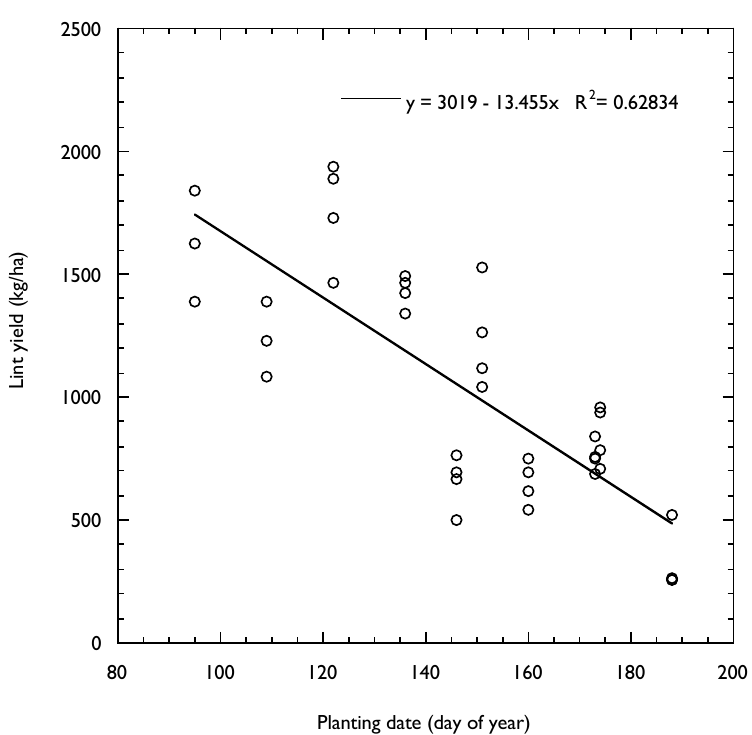
Figure 10. The lint yield as a function of the day of planting for four plantings in 2016 and seven plantings in 2017 with four rain simulations in each planting. R 2 = 0.63.